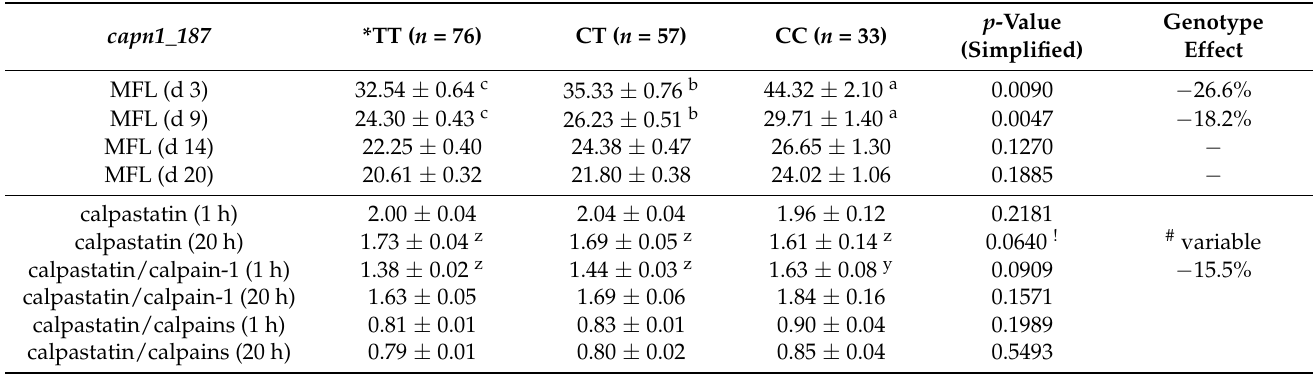
Table 6. The effects of genotype of the capn1_187 SNP on the tenderness phenotype, myofibril fragment length (MFL) of representative purebred South African beef bulls during three to 20 days of ageing and on the muscle protease enzyme system during the first 20 h